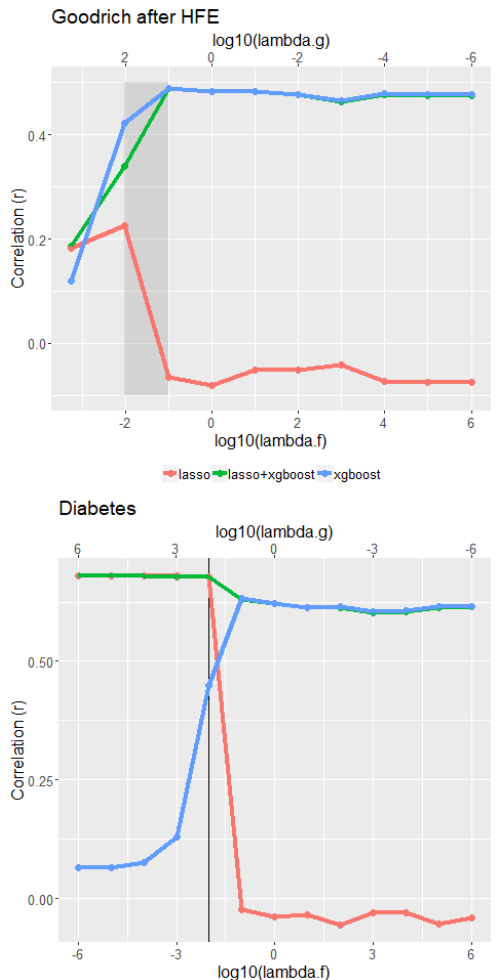
Figure 3. Top panel: cross-validated correlations between y and each of ˆ f , ˆ g , and ( ˆ f + ˆ g ) for the microbiome dataset, where the tuning parameters vary along the transect as described in the text. Bottom panel: the analogous correlations for the diabetes dataset. Grey region and black vertical line represent suggested tuning parameter values to maximize interpretability while preserving high prediction